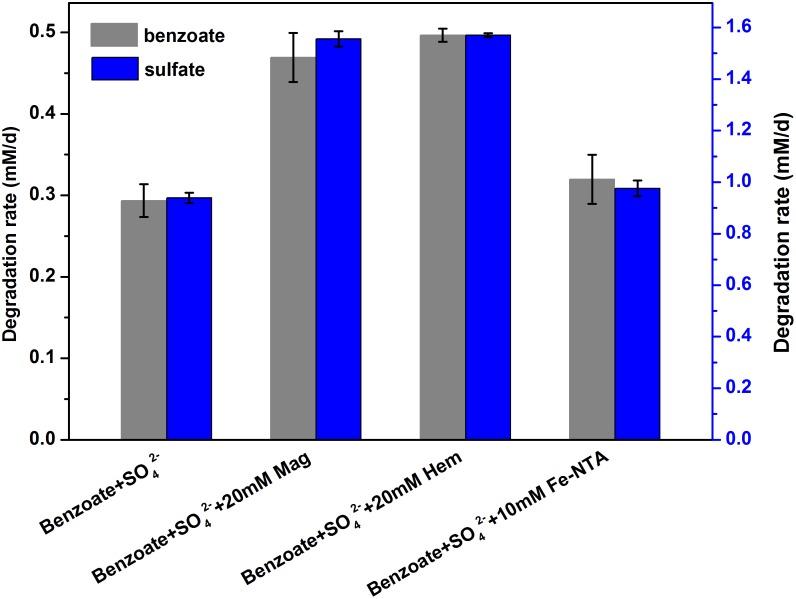
Comparison of the rates of benzoate degradation and sulfate reduction with different iron oxides [NTA-Fe(III), magnetite and hematite]. The different lowercase letters denote significant difference between the four treatments. Mag, Hem, and Fe-NTA denote magnetite, hematite and ferric nitrilotriacetate, respectively.